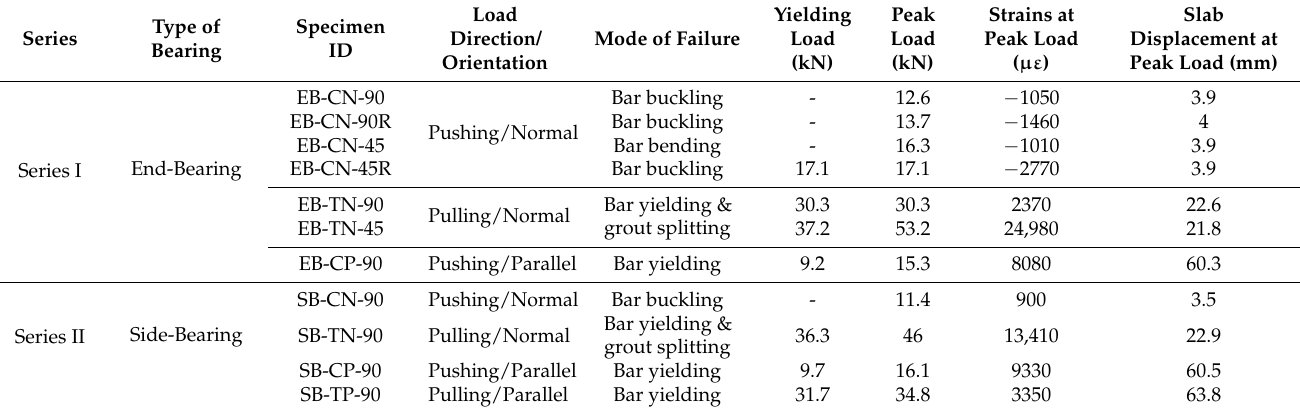
Table 2. Summary of test